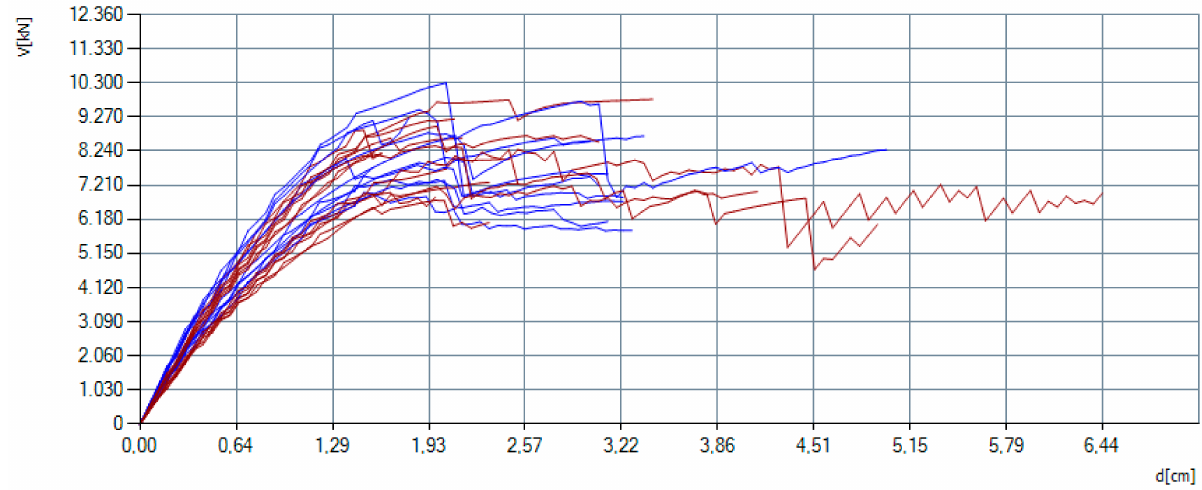
Figure 16. Capacity curves in the x (blue) and y (red)